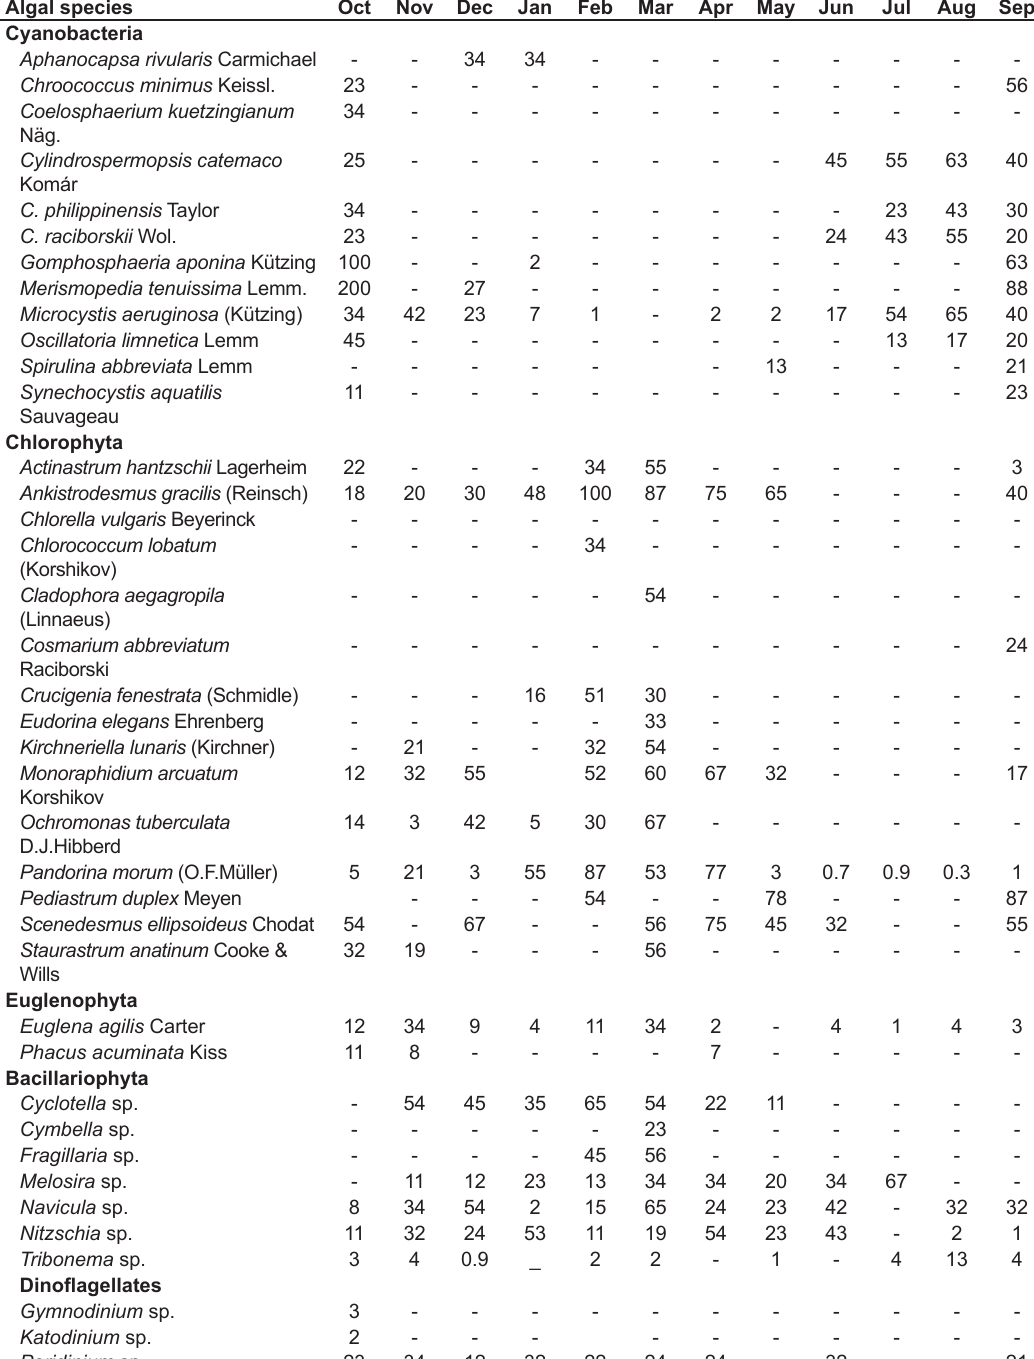
Table 4. Analysis of different phytoplankton groups identified in fish gut (cells x10 6 gut -1 ) from fishpond 3 during the study period Oct. 2012- Sept.